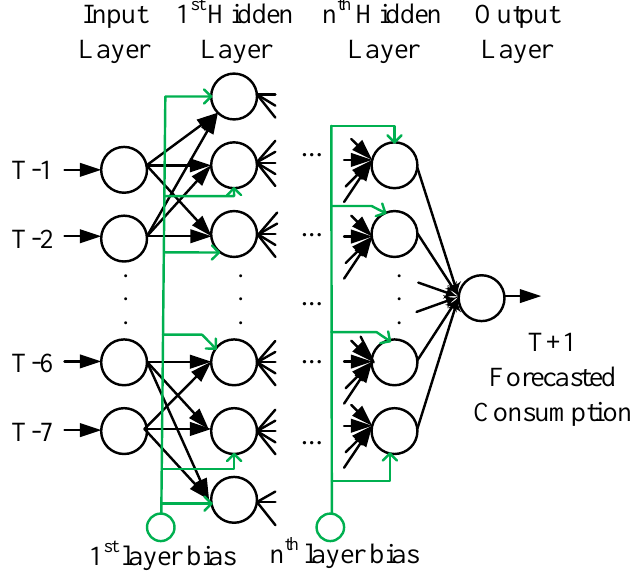
Figure 6. The structure of ANN chosen for